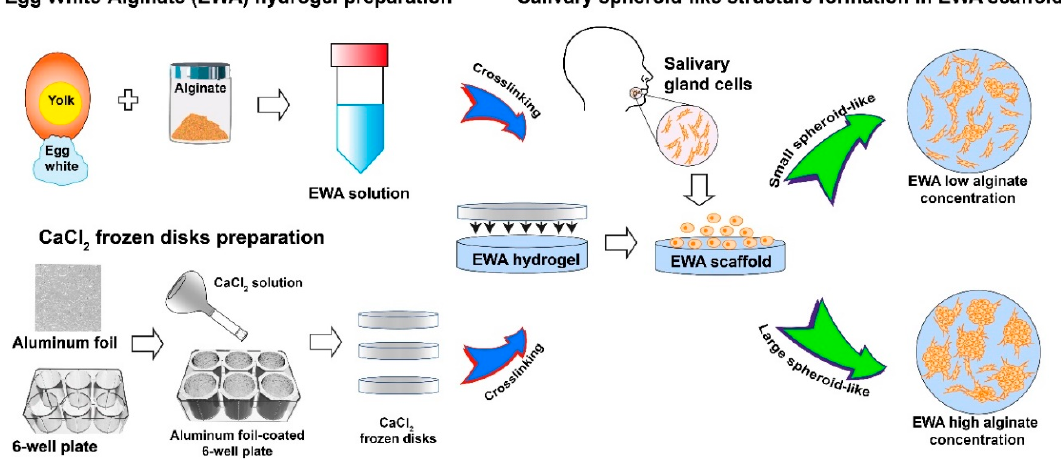
Figure 1. Schematic illustration showing the EWA hydrogel preparation, frozen CaCl 2 disk, and salivary gland spheroid-like structure formation.